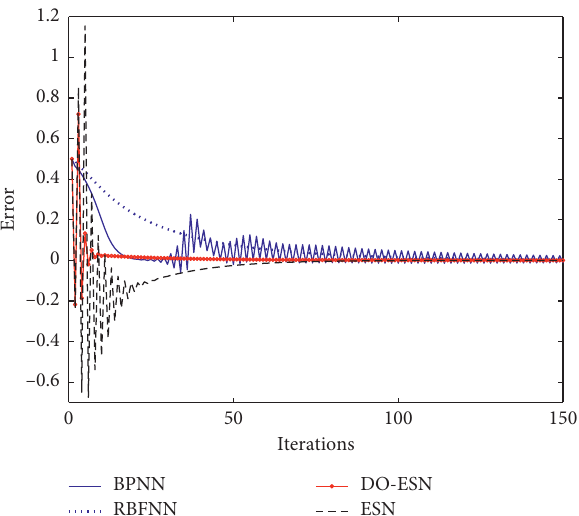
Figure 4: The output error curve of the control